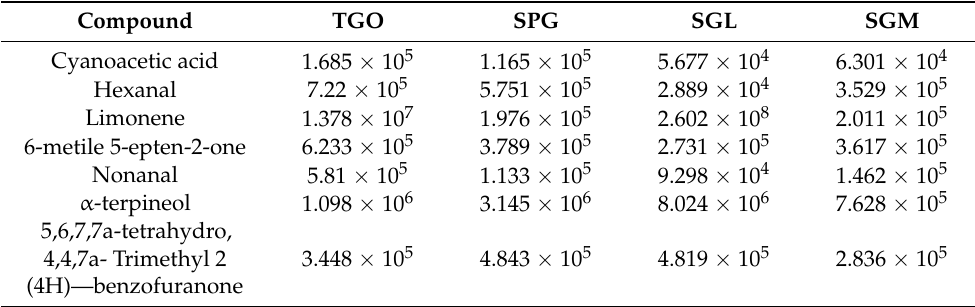
Table 3. Common compounds between the analyzed green